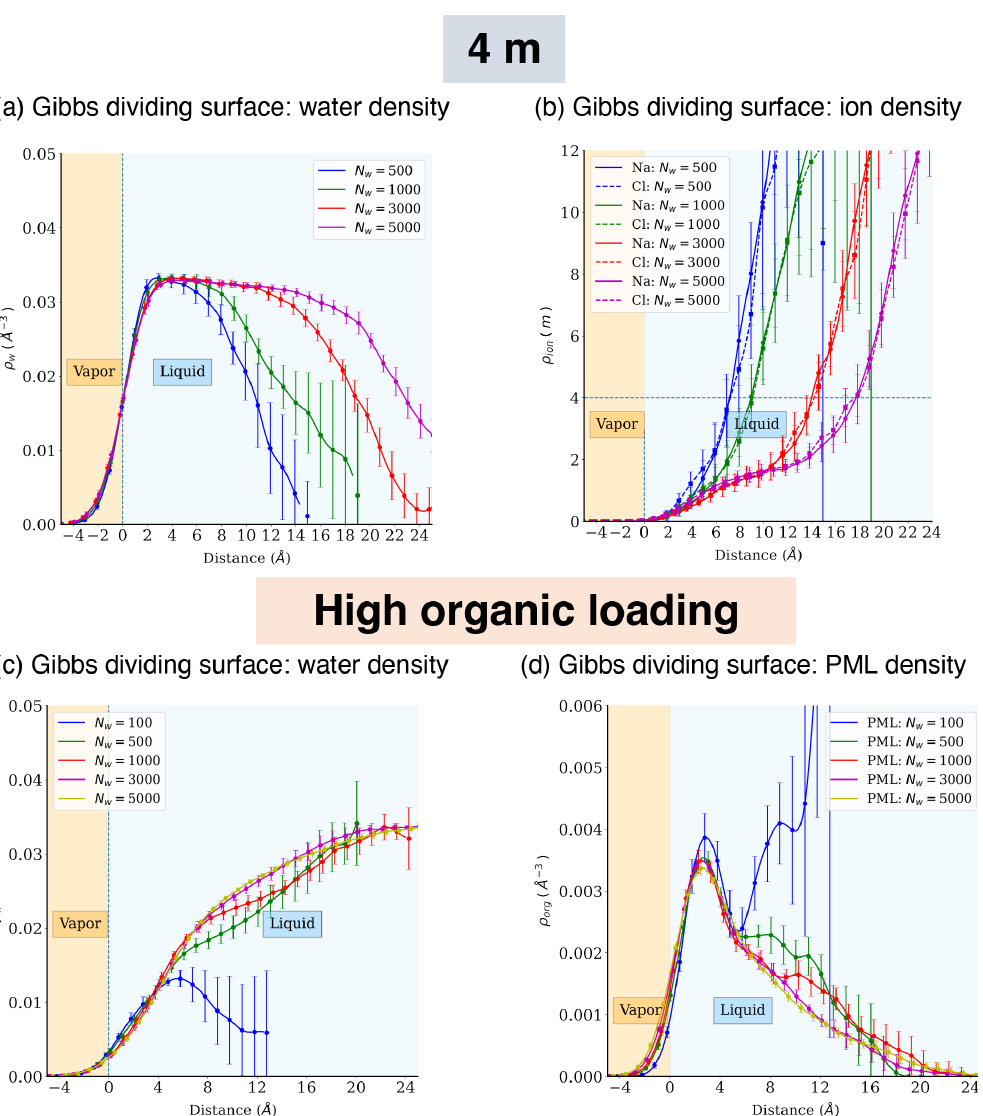
Figure A5. Atomic density profiles of different components relative to distance from the Gibbs dividing surface for the phase-separated systems (4m NaCl or high organic